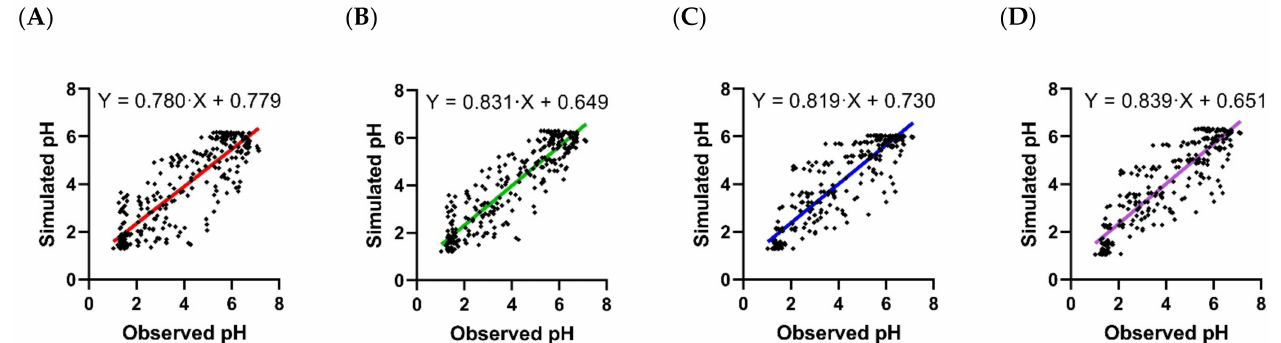
Figure 4. Comparison between observed and simulated pH using four PK–PD models for fex- uprazan. X- and Y-axes represent observed and simulated pH, respectively, after 10, 20, 40, 80, 160, and 320 mg/day. One-compartment–PD ( A ), PBPK–PD ( B ), stomach-indirect–PD ( C ), and stomach-direct–PD ( D ) models estimated simulated pH. Closed diamonds ( and simulated pH at drug effect time points. Red ( A ), green ( B ), blue ( C ), and purple ( D ) lines are the results of the linear regression of markers. r 2 s are 0.738, 0.827, 0.803, and 0.808 for red, green, blue, and purple lines,